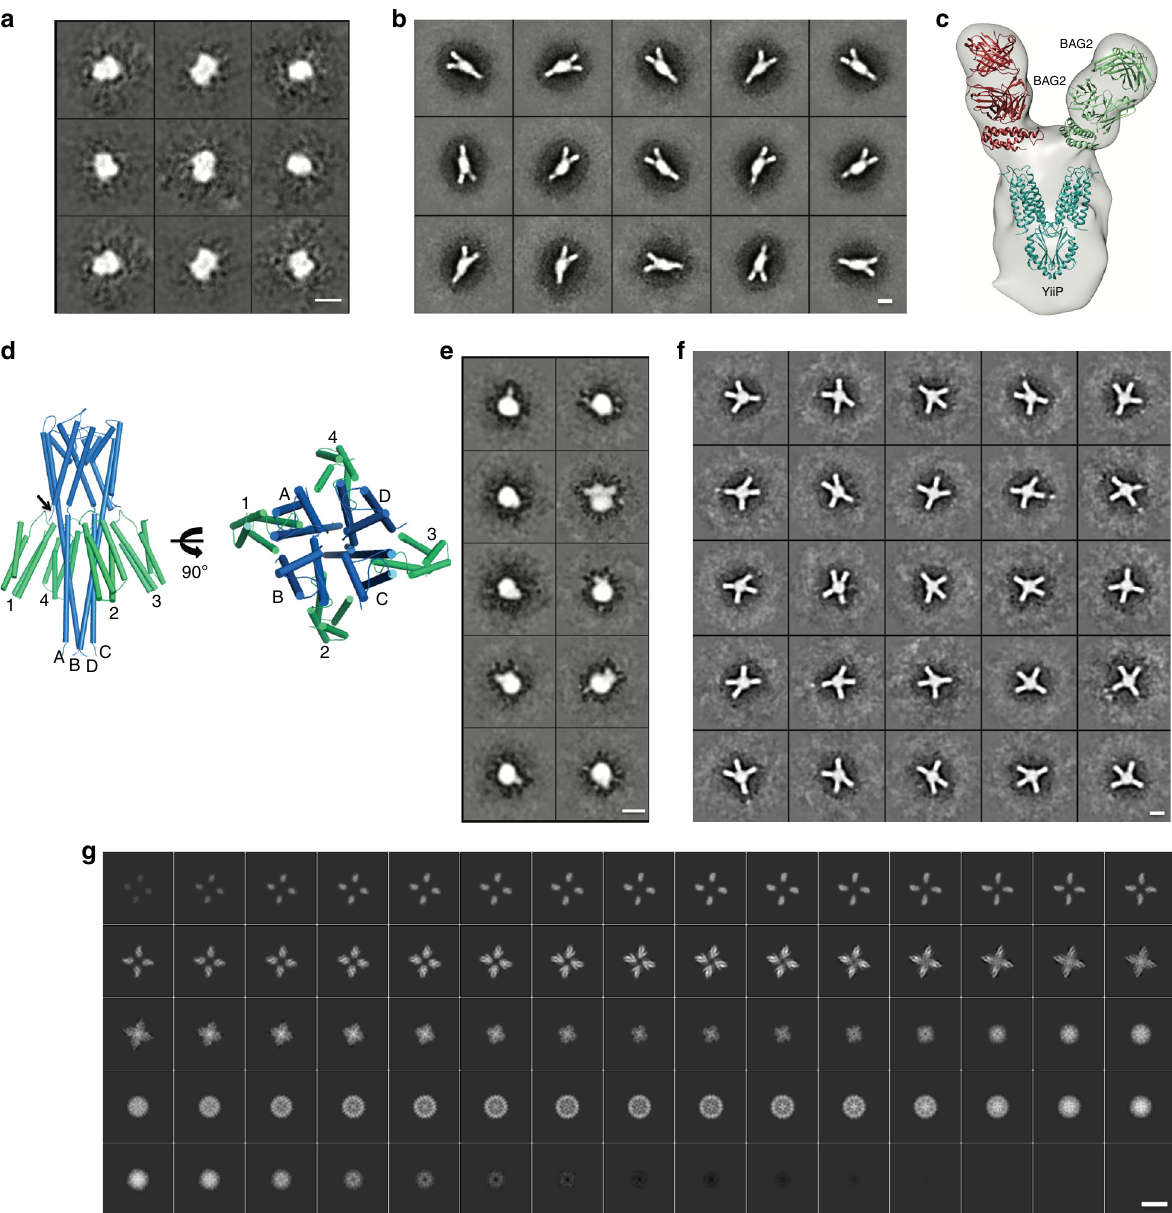
Fig. 5 BAG2 binds to BRIL-fused constructs of different membrane proteins. 2D class averages from negative-stain images of a the zinc transporter YiiP- BRIL alone. b YiiP-BRIL bound to BAG2. Micrographs of YiiP-BRIL bound to BAG2 is shown in Supplementary Fig. 4b. c Three-dimensional map of YiiP- BRIL-BAG2 complex generated in cryoSPARC from the 2D class averages in (b). Crystal structures of YiiP (colored teal, PDB ID: 3H90) and BRIL – BAG2 (two copies colored red and green respectively, PDB ID: 6CBV) were fi tted into the low-resolution map using Chimera. d Model of BRIL-(linker)-KcsA. The N-term helix of KcsA (aa residues: 1 – 23) was replaced with BRIL. The point of attachment is marked with an arrow. 4 copies of BRIL (labeled 1, 2, 3, 4; colored green) are fused to four copies of KcsA (labeled A, B, C, D; colored teal). Different helical linkers to fuse BRIL with KcsA were tested. 2D class averages from negative-stain images of e BRIL-2turn-KcsA alone f BRIL-2turn-KcsA bound to BAG2. Associated micrographs are in Supp. Figure 4c. g Volume slices through 3D reconstruction of the BRIL-3turn-KcsA/BAG2 complex from the cryoEM data. All scale bars in this fi gure are 100 nm. Representative cryoEM micrograph of the complex is in Supplementary Fig.